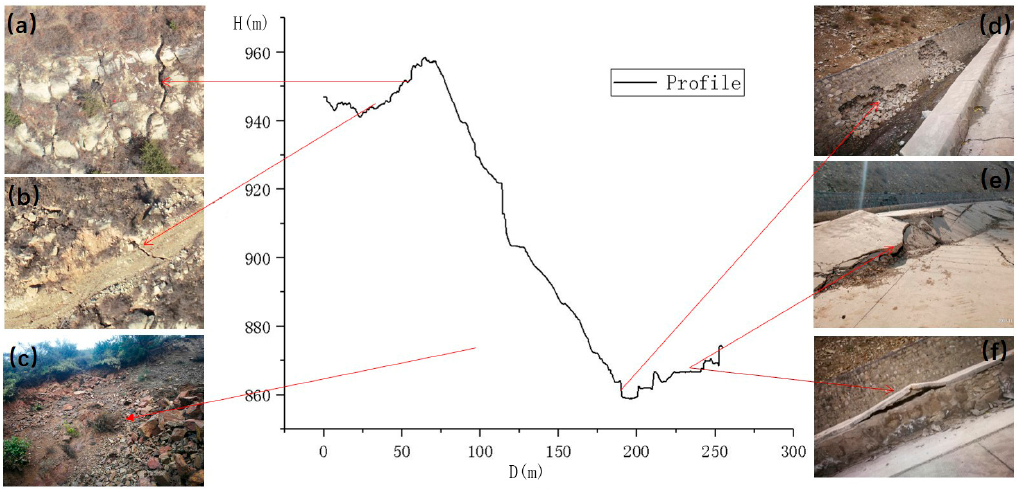
Figure 12. Landslide damage in Luhu village as a consequence of